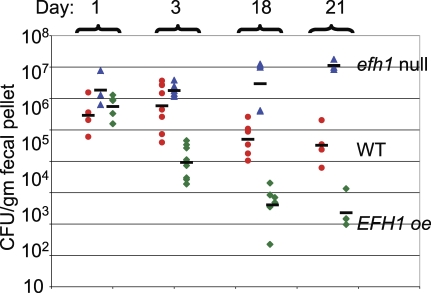
Attenuated Colonization of Mice by an EFH1 Overexpressing StrainCells of WT strains CKY363 or DAY185, efh1 deletion mutant strain CKY366, and EFH1 overexpressing strain CKY364 were orally inoculated by gavage. At various days post-inoculation, fresh fecal pellets were recovered from inoculated mice and the amount of C. albicans per gm was measured. Red circles, CKY363 or DAY185 (WT) (seven mice); blue triangles, efh1 deletion mutant strain CKY366 (six mice); dark green diamonds, CKY364 (EFH1 overexpressing) (eight mice); bars, geometric means. Composite results of two experiments are shown. Different numbers of mice are shown on different days because some mice were sacrificed earlier and some mice were sampled on different days.